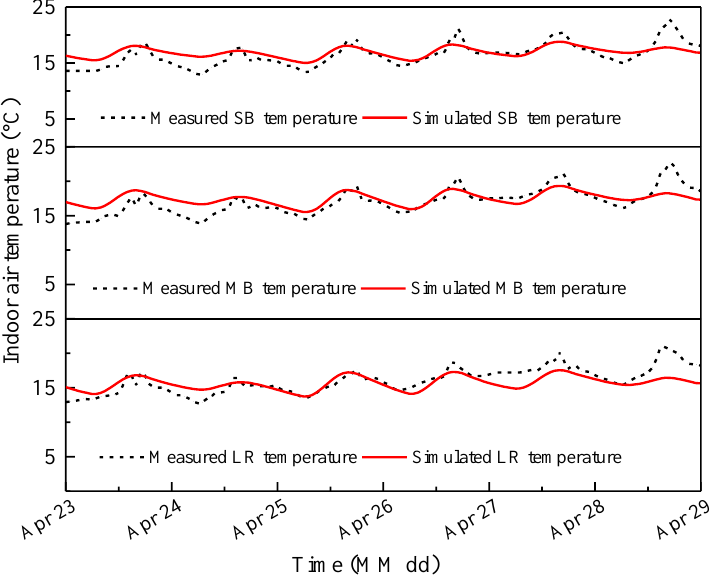
Figure 5. Comparison of the simulated and measured temperatures during the test period.